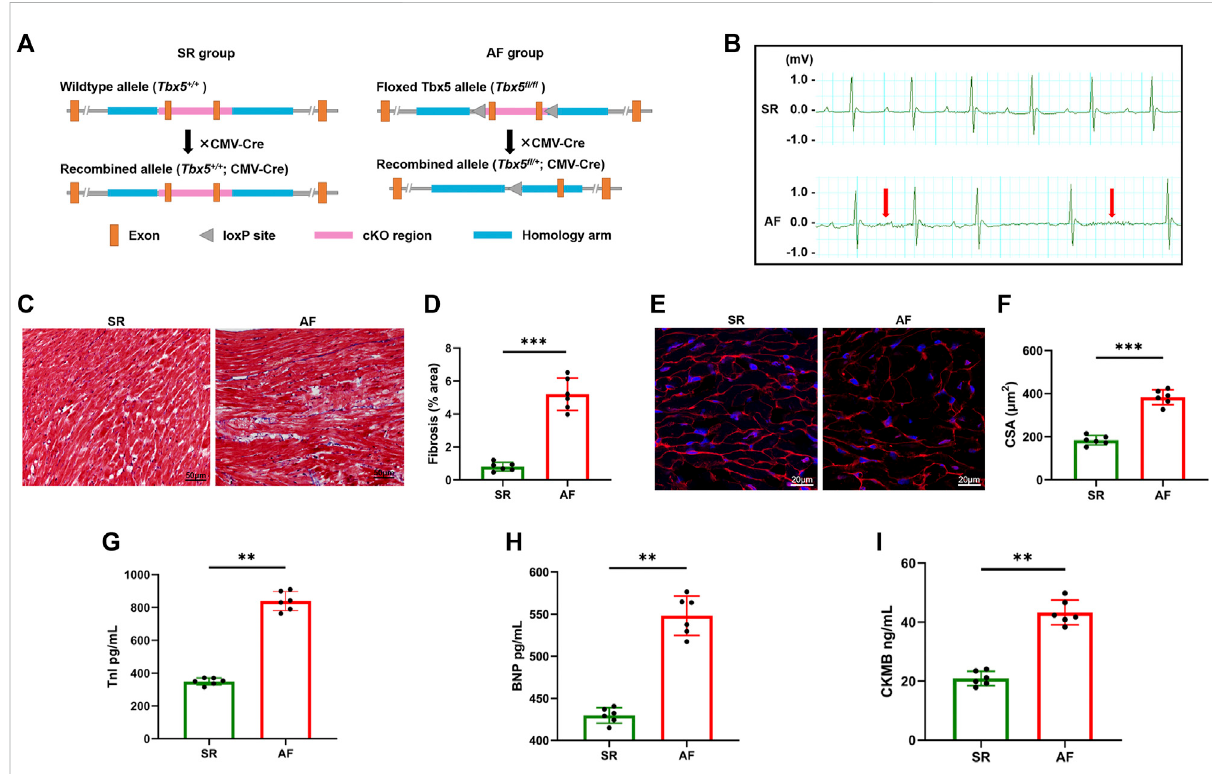
FIGURE 1 Histologicalandcellularchangesintheheartsofatrial fi brillationmousemodels. (A) ,ExperimentalschemaofAFmicemodel.Male Tbx5 +/ − mice ( Tbx5 fl /+ ; CMV-Cre) and CMV-Cre mice were used as SR and AF mice respectively. (B) ECG tracing of SR mice (upper) and AF mice (lower); rapid and irregular atrial waves are indicated by red arrows. (C) Histological images of hearts from SR and AF mice obtained by Masson ’ s trichrome staining. Scale bar: 100 μ m (right panel). (D) The degree of fi brosis was evaluated and calculated by measuring the blue regions (collagen) relative to the total tissue area in sections, as shown in (C) . (E) Representative images stained with WGA (red) to delineate the sarcolemma, and DAPI (blue). Scale bar, 20 μ m. (F) Quanti fi cation of the CSAs of atrial cardiomyocytes. (G – I) Statistics of plasma concentrations of BNP, TnI, and CK-MB in mice in two groups. AF, atrial fi brillation; SR, sinus rhythm; ECG, electrocardiogram; WGA, wheat germ agglutinin; CSA, cross-sectional area; BNP,